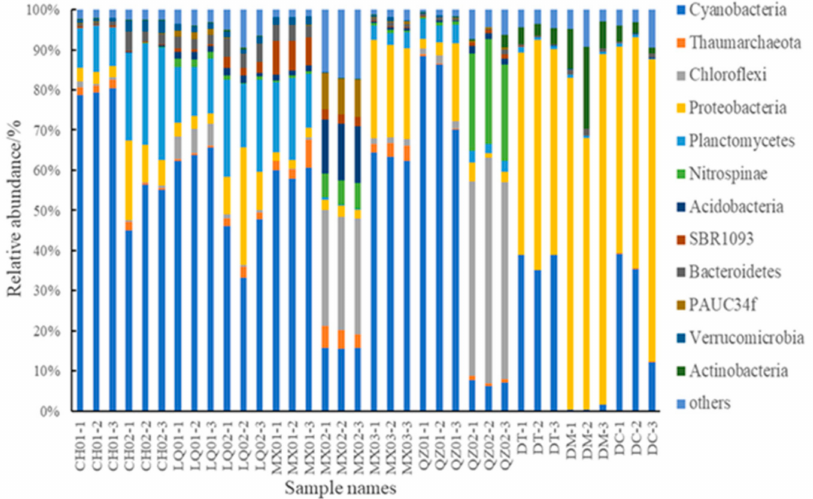
Figure 2. The microbial community composition and abundance patterns in the level of phyla of di ff erent taxonomic groups from 36 sponge samples. CH01: Haliclona sp., CH02: Cladocroce sp., LQ01: Lissodendoryx sp., LQ02: Mycale sp., MX01: Lissodendoryx sp., MX02: Ircinia dendroides,